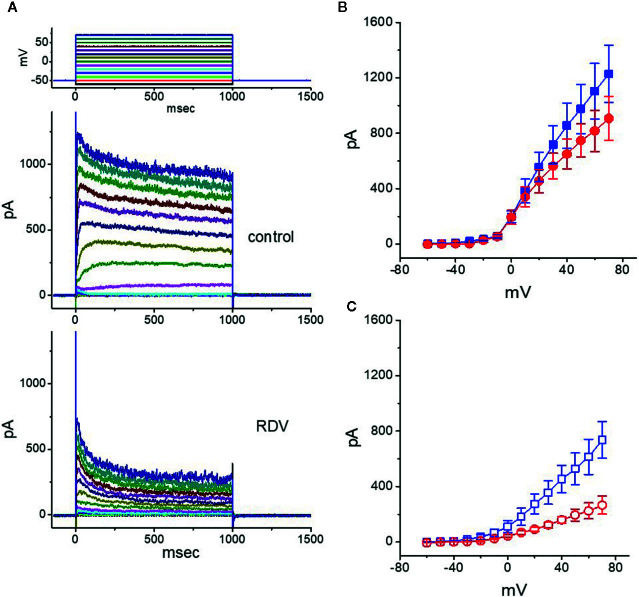
Effect of RDV on the current-voltage (I-V) relationship of I
K(DR) in GH3 cells. In the experiments on the elicitation of I
K(DR), the cell was maintained at −50 mV and 1-sec depolarizing command pulse to a series of voltage steps ranging between −60 to +70 mV in 10-mV increments was thereafter applied. (A) Representative I
K(DR) traces obtained in the control (upper) and during cell exposure to 10 μM RDV (lower). The uppermost part shows the voltage protocol delivered. In (B, C), the averaged I-V relationships of I
K(DR) obtained in the absence (filled symbols) and presence (open symbols) of 10 μM RDV are illustrated, respectively (mean ± SEM; n=8 for each point). The data points in (B, C) were collected at the beginning (initial peak component, square symbols) or end (late component, circle symbols) of 1-sec depolarizing pulse.